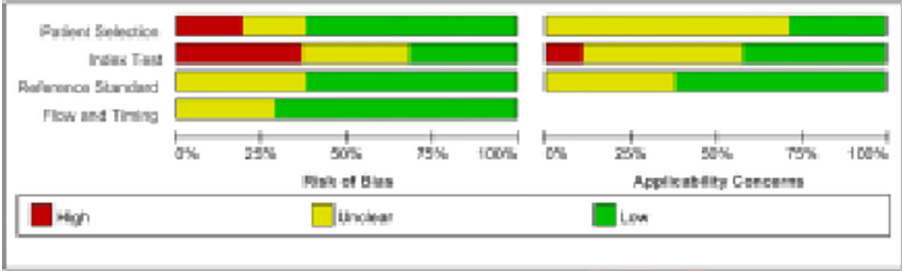
Fig 3. Results of the quality evaluation of the included literature. Red represents high degree of bias, yellow represents unclear and green represents a low degree of